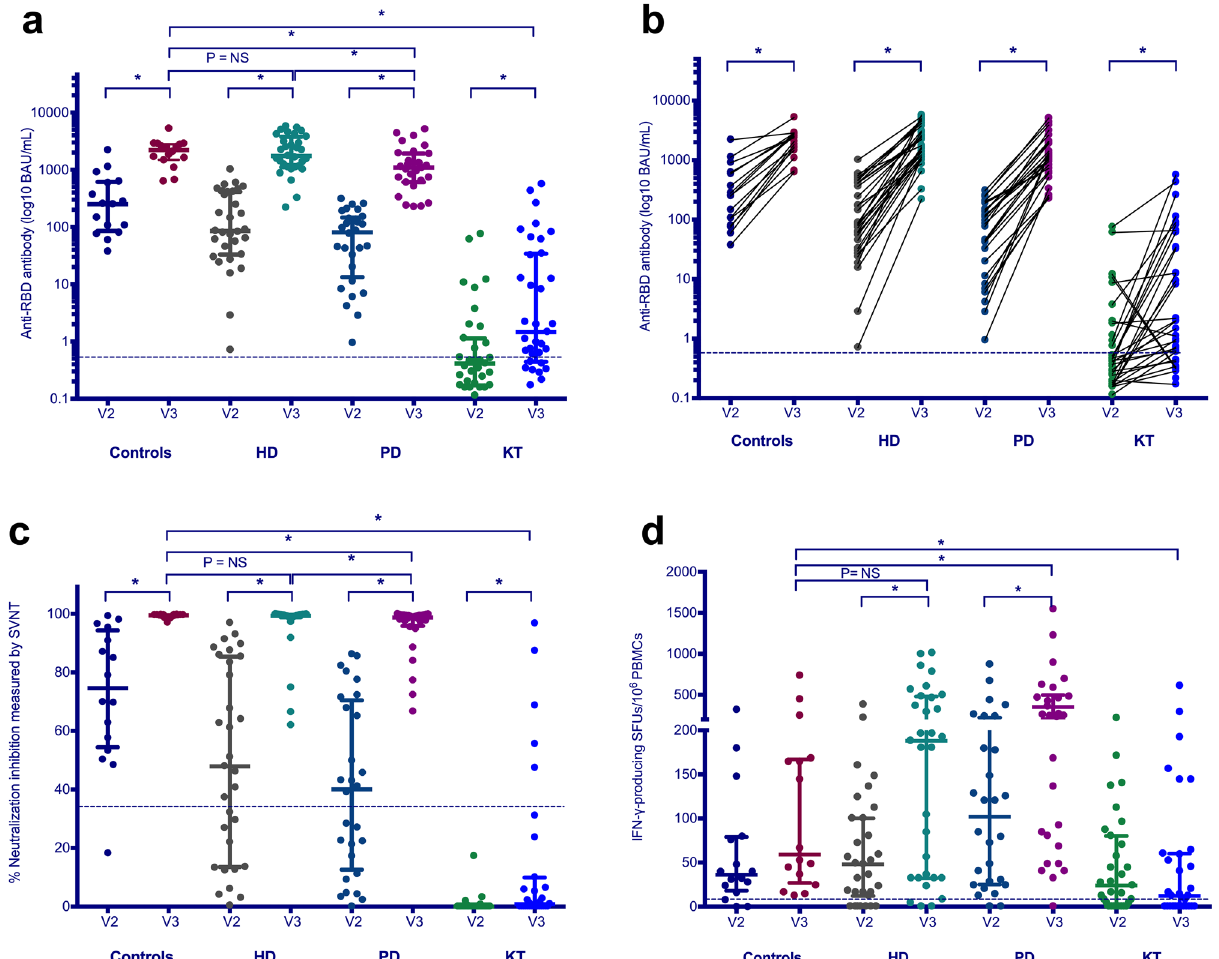
Figure 1. Humoral and cell-mediated immune responses in kidney transplant (KT), peritoneal dialyzed (PD), and hemodialyzed (HD) patients and healthy individuals (controls) who received two doses of inactivated vaccine (V2) compared with those receiving a third dose of ChAdOx1 nCoV-19 vaccine (V3). ( a ) Anti-receptor- binding domain (RBD) antibody levels at two weeks after V2 and V3 are presented in log10 binding antibody units (BAU)/mL using scatter dot plots. Each dot represents an individual participant, and horizontal lines indicate the median and interquartile range. The dotted line indicates the threshold value of 7.1 BAU/mL. (n = 106) ( b ) Anti-RBD antibody levels at two weeks after V2 and V3 within individuals are shown. (n = 106) ( c ) The percent neutralization inhibition at two weeks after V2 and V3 are presented. The dotted line indicates the 35% threshold for neutralization positivity. (n = 106) ( d ) SARS-CoV-2–specific, IFN-γ-producing T-cell responses to the S1 protein at two weeks after V2 and V3 are presented in the scatter dot plots. (n = 106) Horizontal lines indicate the median and interquartile range. The dotted line indicates the threshold value of 6 SFUs/10 6 PBMCs. * P -value < 0.05. IFN-γ, interferon-γ; SFU, spot forming unit; NS, non-significant; PBMCs, peripheral blood mononuclear cells; S, spike glycoprotein; S1, S1 domain of spike